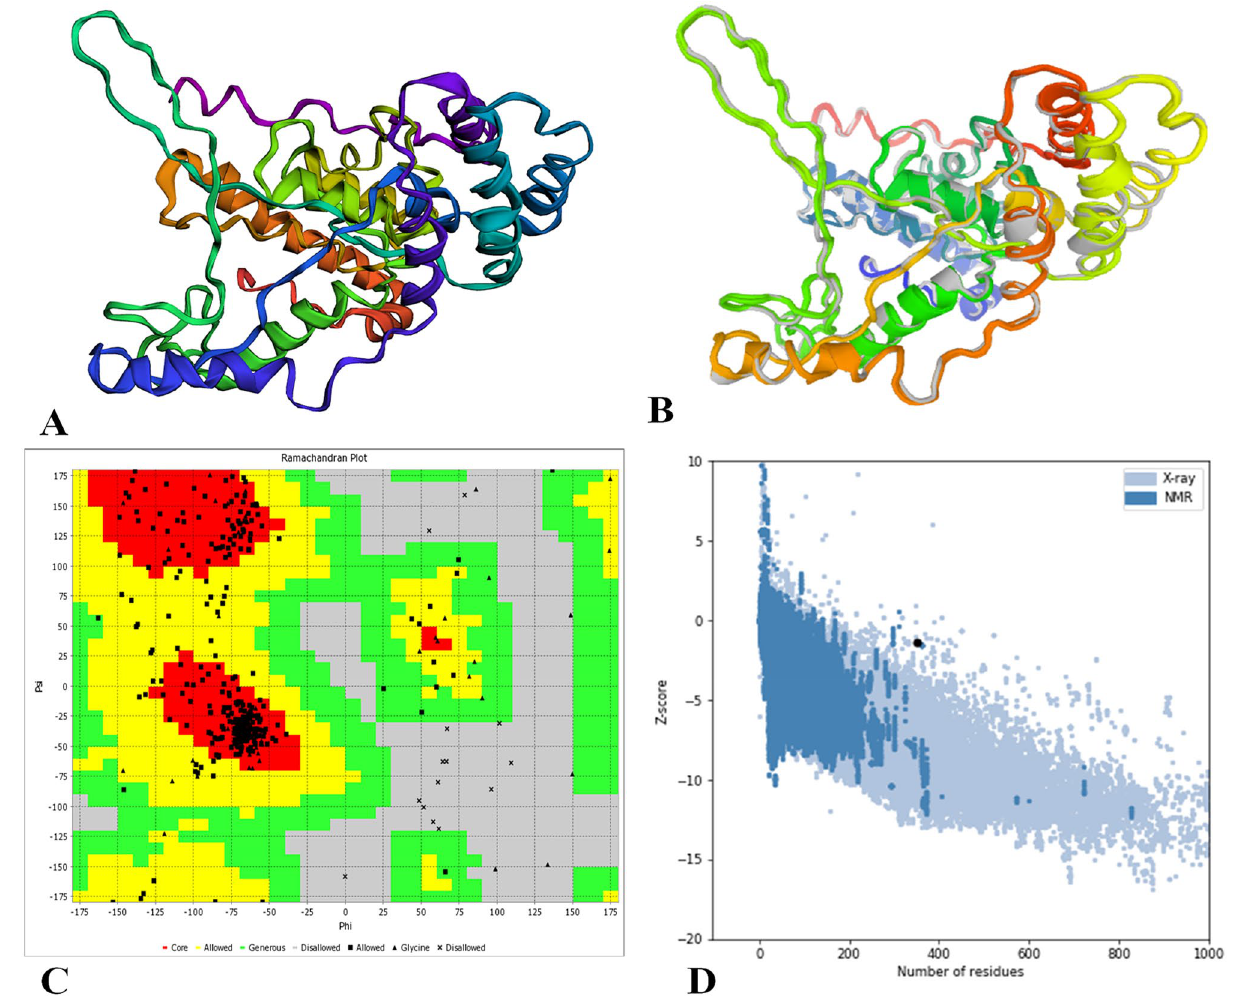
Figure 3. Protein 3D modeling, refinement, and validation. ( A ) The 3D model of a multi-epitope vaccine was obtained on the I-TASSER server following homology modeling. ( B ) Refinement: superimposition by the GalaxyRefine server of a refined 3D structure (colored) on a ‘crude model’ (gray). ( C ) Validation: Ramachandran plot analysis showing 85.9% in favored, 8.9% in allowed, and 5.2% in disallowed regions of protein residues and ( D ) ProSA-web, with a Z score of −